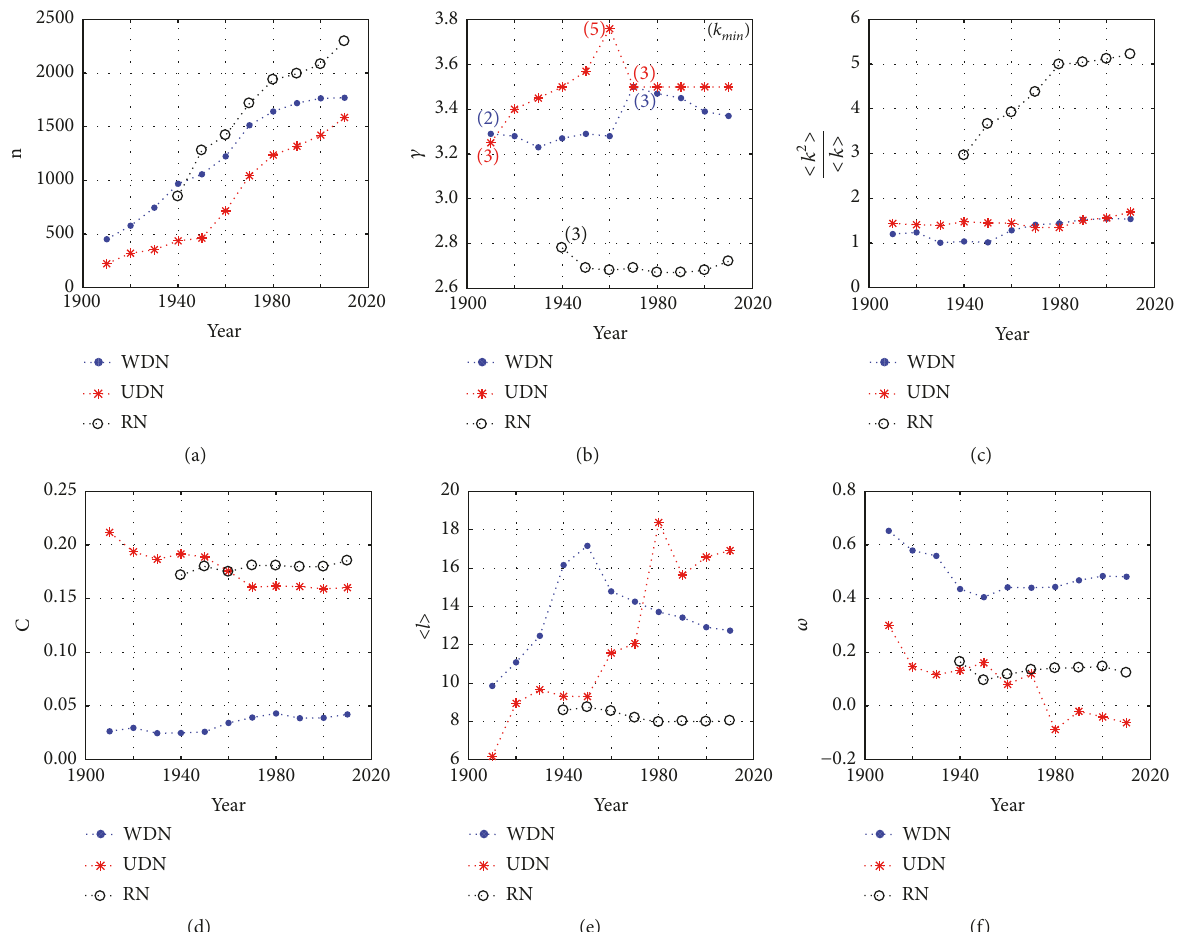
Figure 6: Topological properties of coevolving WDN, UDN, and RN: (a) number of vertices 𝑛 ; (b) power-law exponent 𝛾 ; (c) dispersion index ; (d) clustering coefficient 𝐶 ; (e) characteristic path length ⟨𝑙⟩ ; and (f) small worldness 𝜔 .